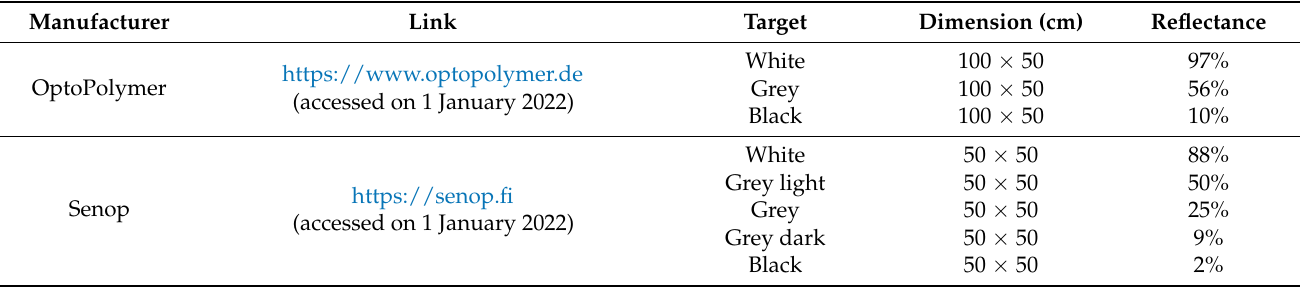
Table 2. Reflectance reference panels used in this research.